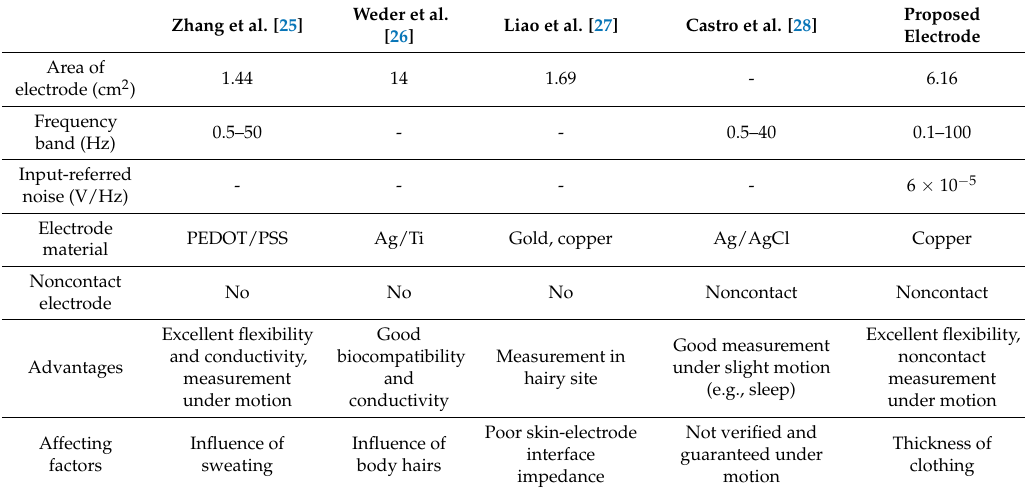
Table 1. The specification comparisons between different dry and noncontact electrodes and the proposed noncontact electrode.